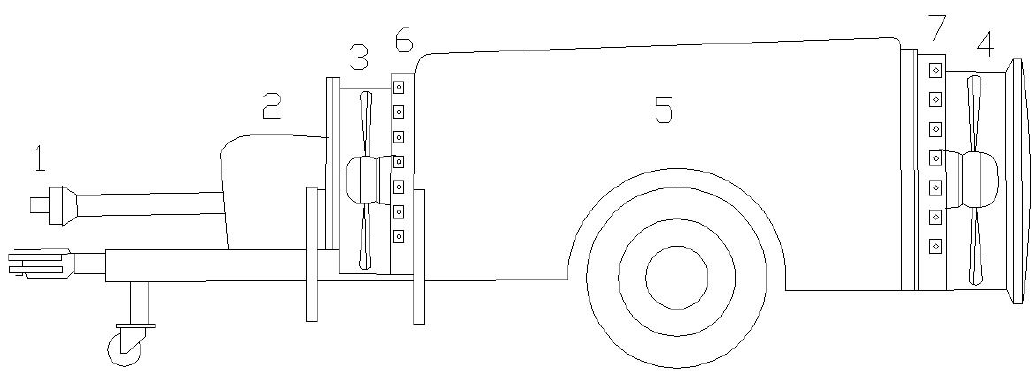
Figure 1. Air assisted sprayer equipped with two reversed rotation axial fans. 1 PTO; 2 Pump; 3 Front fan; 4 Back fan; 5 Tank; 6 Front nozzles; 7 Back